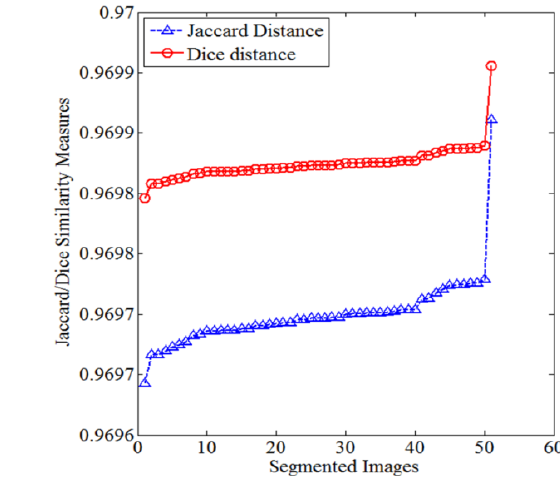
Fig. 7. Accuracy. Fig. 8. Jaccard and